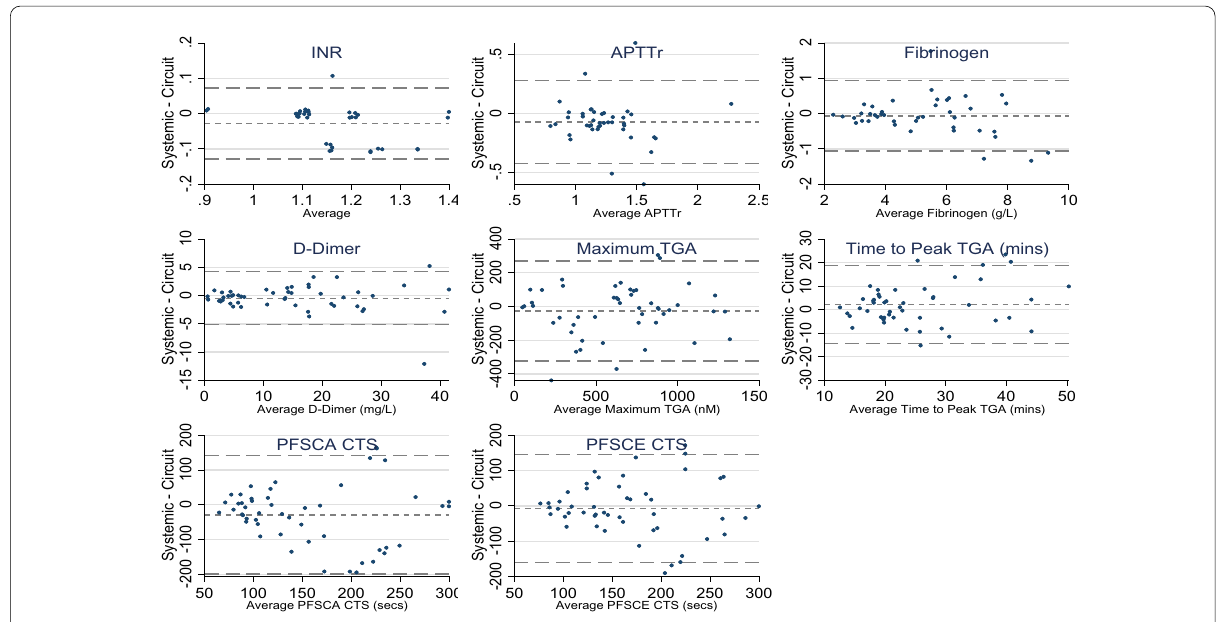
Fig. 4 Bland–Altman plots showing difference between systemic and circuit measurements. INR International Normalised Ratio, APTTr activated partial thromboplastin time ratio, TGA thrombin generation assay, PFSCA platelet function assay using collagen/adenosine diphosphate, PFSCE platelet function assay using collagen/epinephrine, CT closure time. Lines shown represent the mean differences in systemic and circuit measurements and 95% limits of